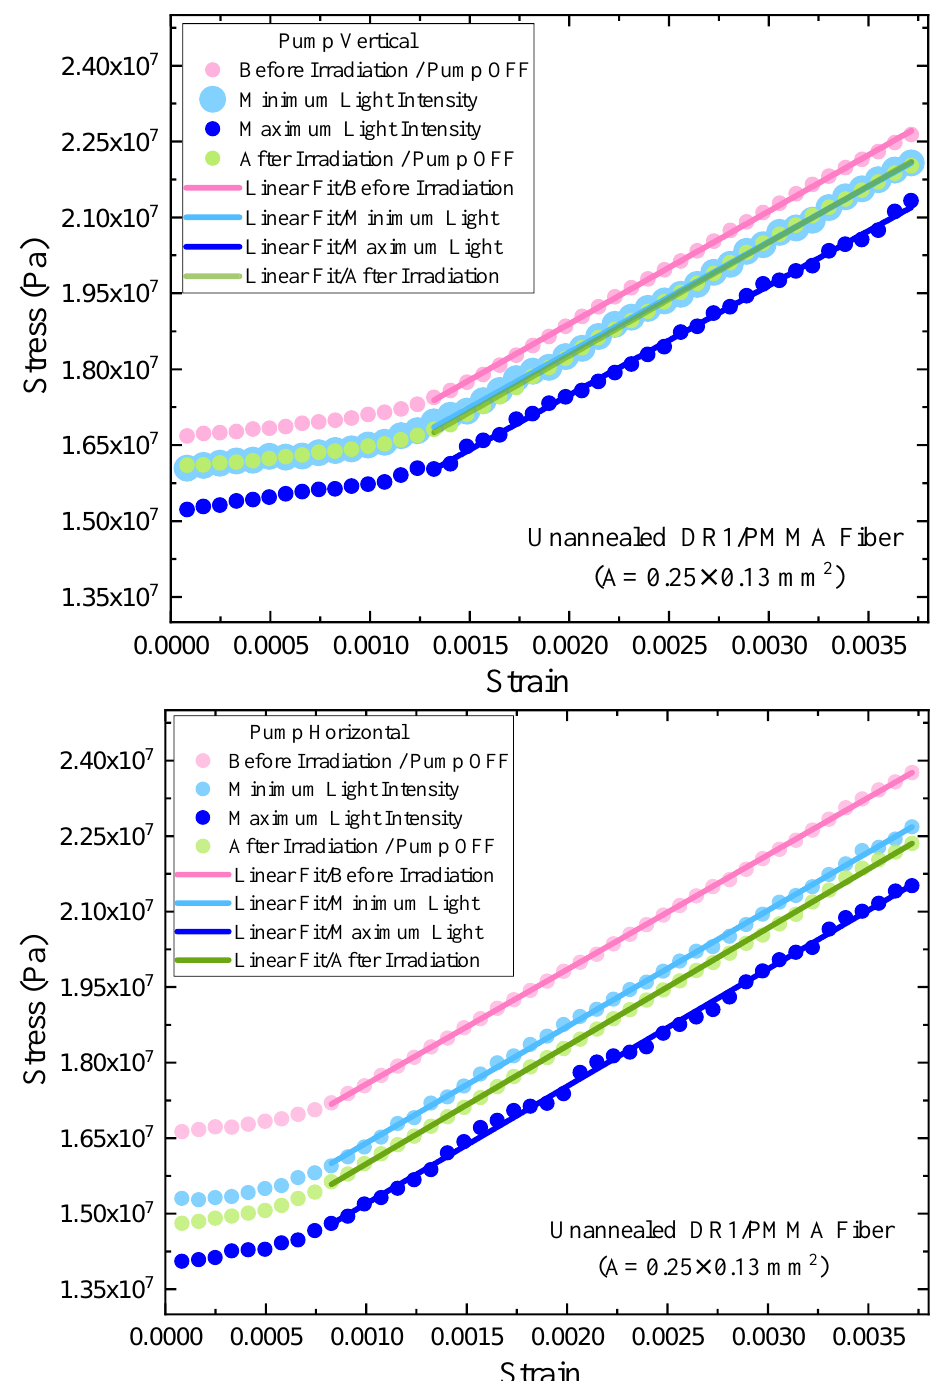
Figure 9. Stress versus Strain of unannealed DR1/PMMA fiber before, during, and after visible light irradiation with vertical and horizontal